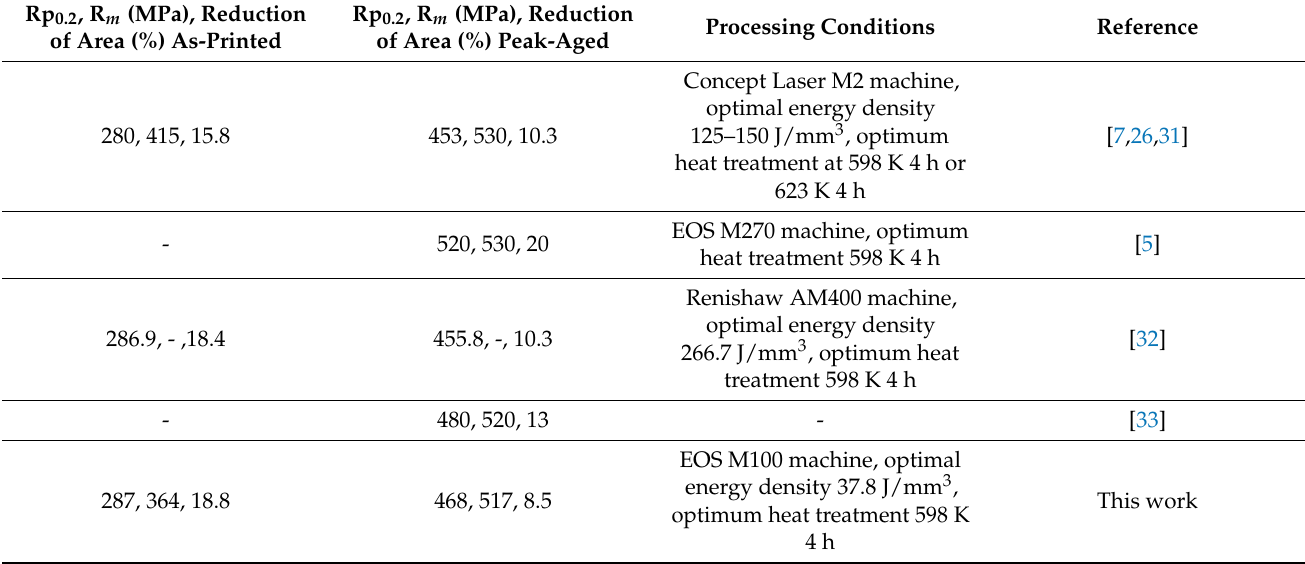
Table 5. Summary of tensile properties of Scalmalloy ® comparing yield strength (Rp 0.2 ), ultimate tensile strength (R m ) and reduction in area in as-printed and peak-aged conditions. Rp 0.2 , R m (MPa),